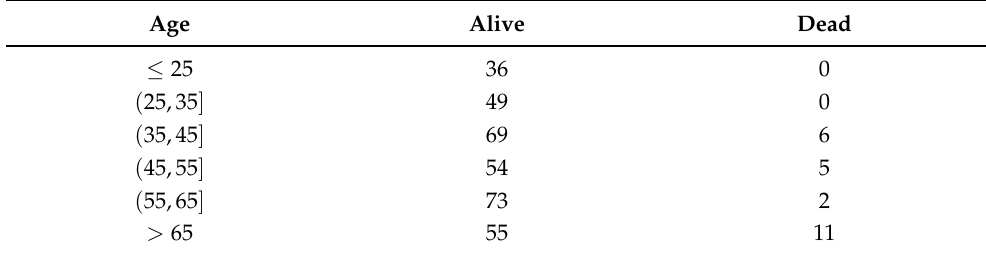
Table 8. Contingency table for exposure age to Mortality.